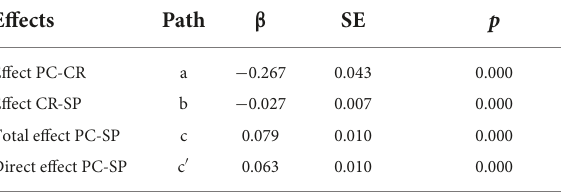
TABLE 2 Testing the mediation effect of cognitive reappraisal on social